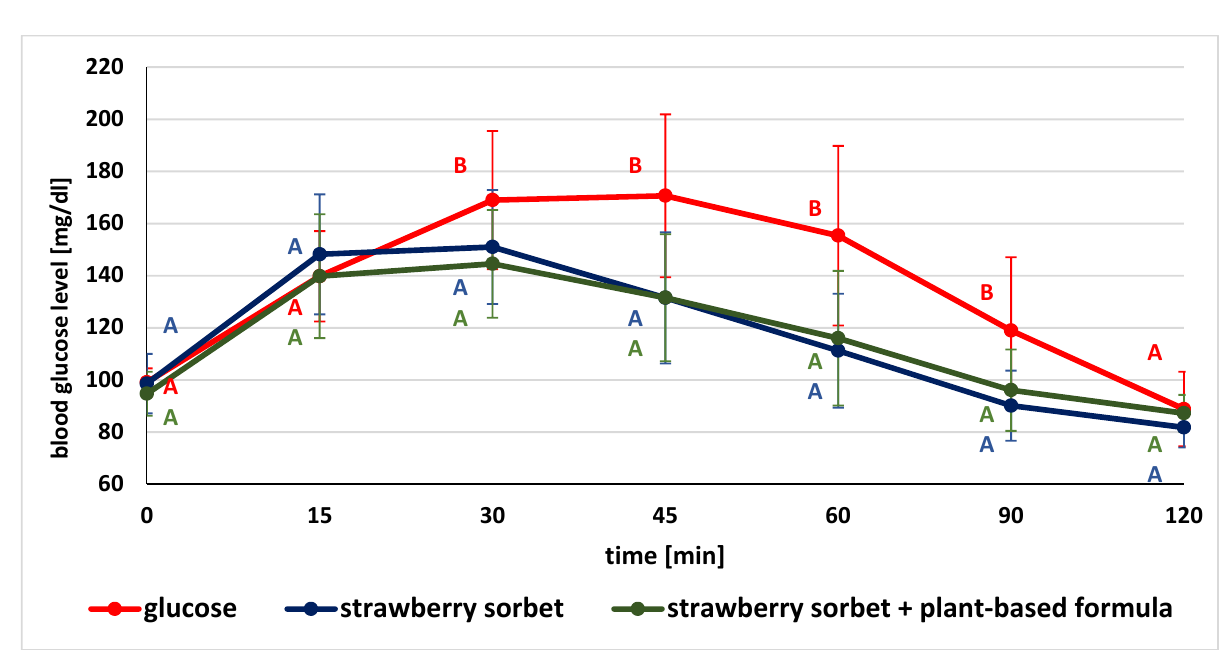
Figure 4. Comparison of mean blood glucose level after consumption of standard glucose solution and sorbet without and with the plant-based formula (for variables with the same letter, the difference is not statistically significant; error bars represent standard deviation, p > 0.05; one-way repeated-measures ANOVA).